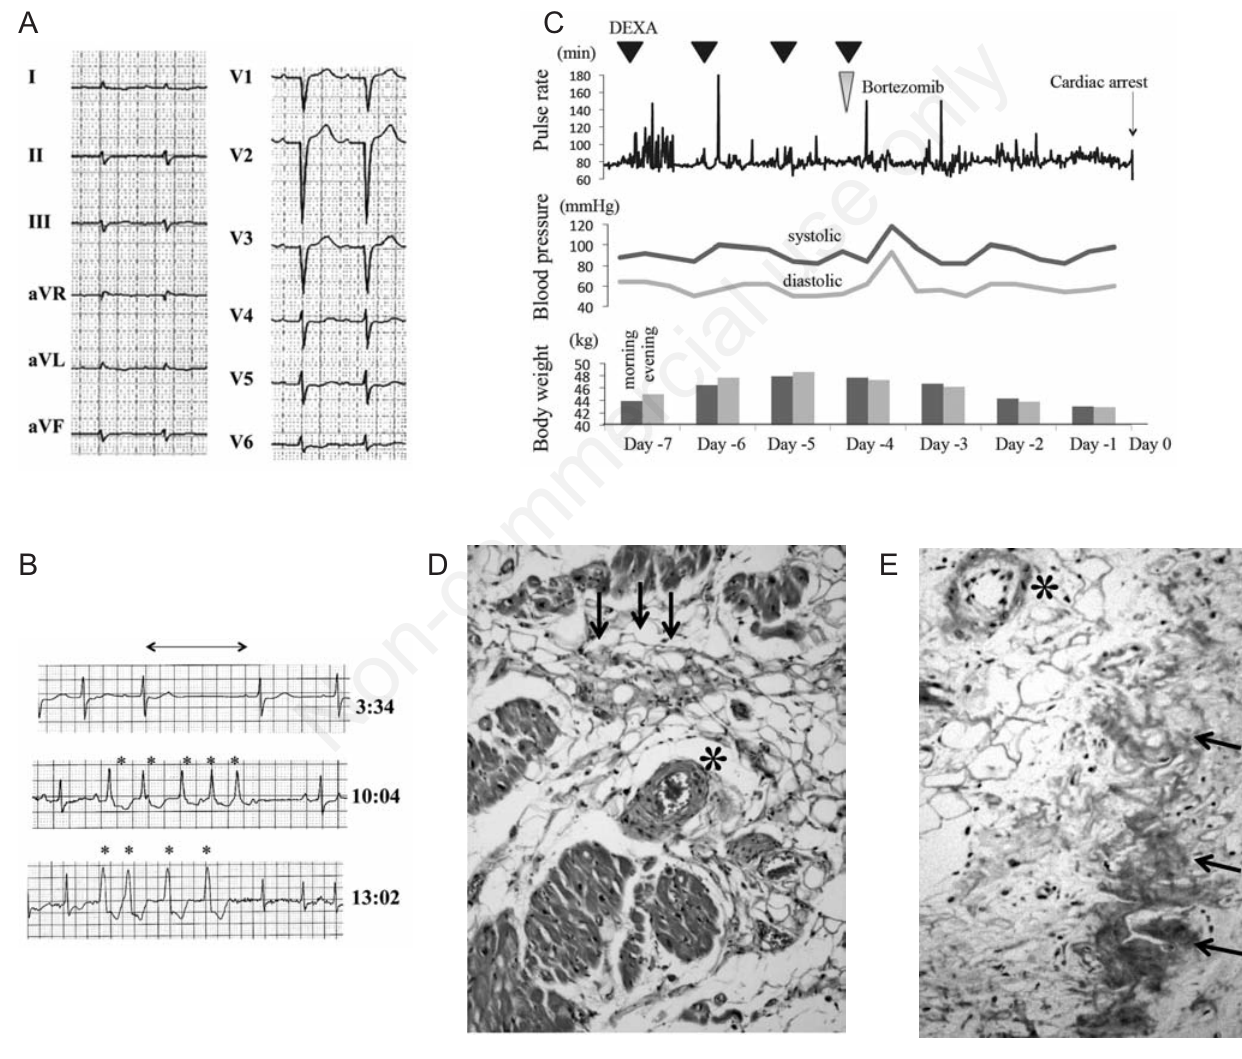
Figure 1. A) Low-voltage of QRS complexes and the absence of P wave in all leads on electrocardiography (ECG) performed on hospi- tal admission. B) The results of 24-h Holter ECG reveal a long pause (arrow) and short-run of premature contractions (asterisks). C) Results from a continuous bed-side monitoring device during 1 week around bortezomib subcutaneous injections. The day when the cardiac arrest occurred is referred to as day 0. DEXA, dexamethasone. D) Histopathological analyses of the region of atrioventricular nodes. Deposits of amorphous materials (arrows) can be seen in a hematoxylin and eosin stained section (x100). E) The amorphous deposits (arrows) are stained positively by Congo-red (x100). The asterisks indicate perivascular amorphous materials that are positive- ly stained with